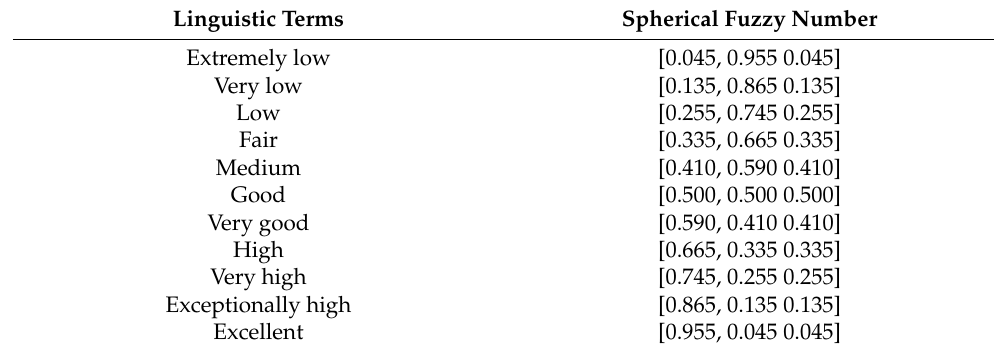
Table 9. Eleven-point spherical fuzzy linguistic term scale